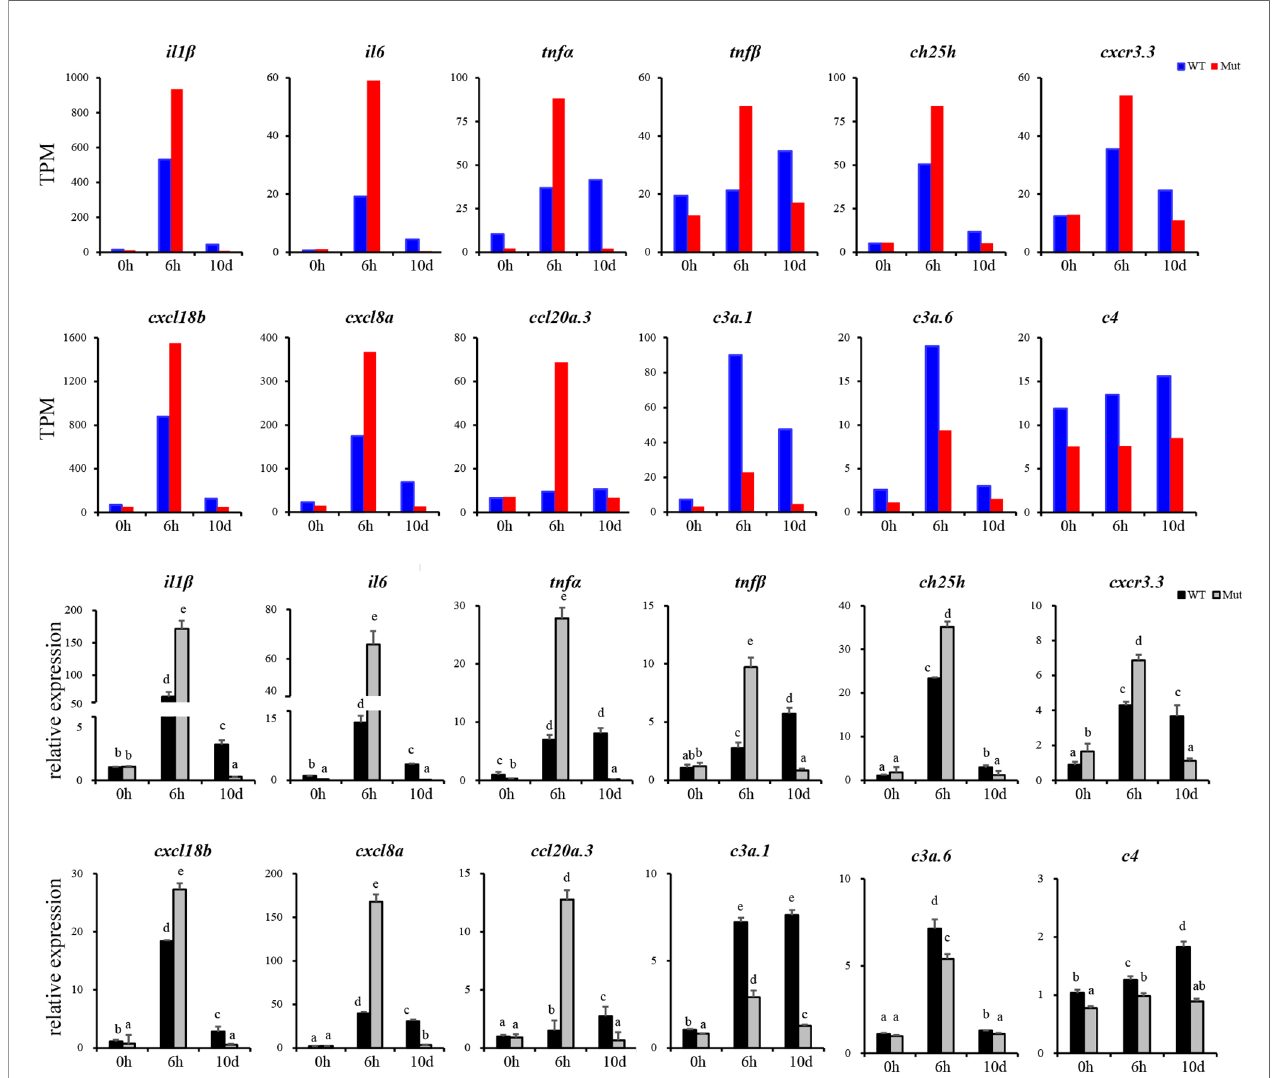
FIGURE 8 | Validation of the 12 DEGs by qRT-PCR. WT animals and congenitally asplenic zebra fi sh sampled at 0 h were used as controls. The data were normalized to the expression level of WT-0h. The data are reported as the mean ± SEM. Different letters (a, b , c etc.) indicate signi fi cant differences ( p